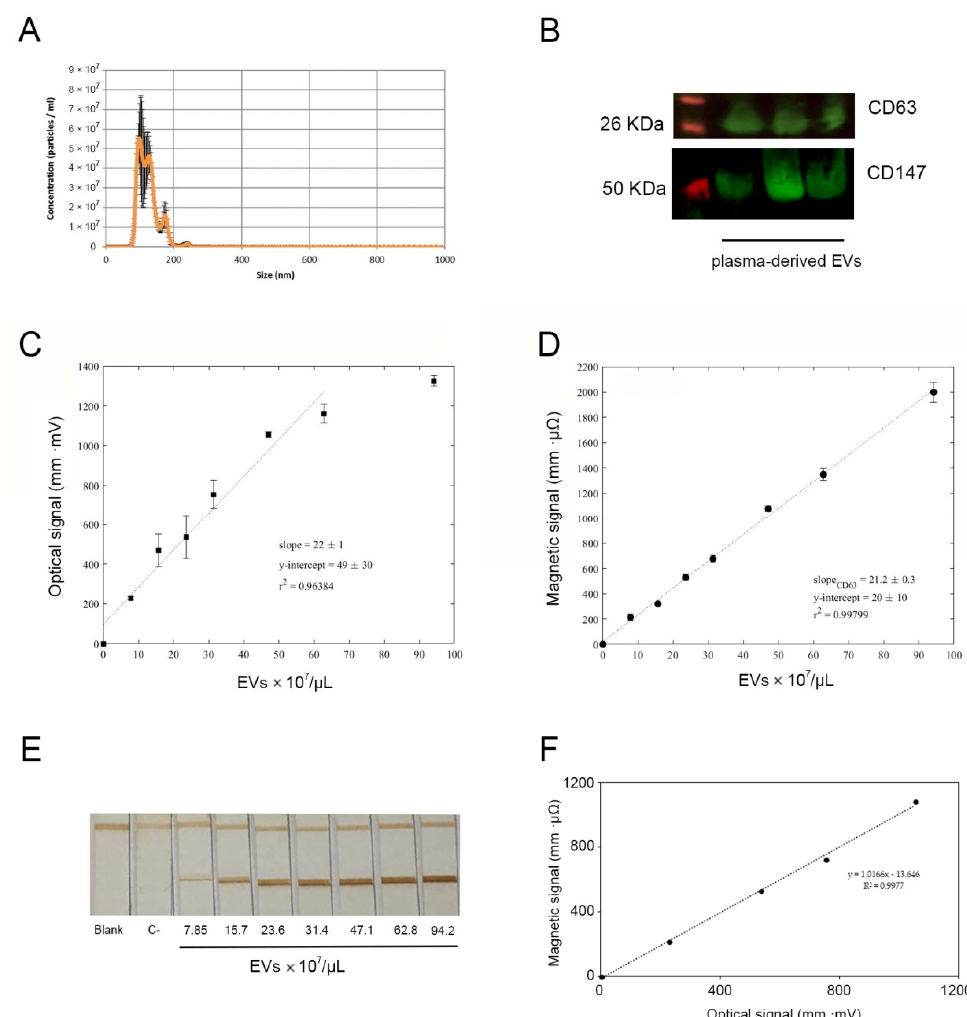
Figure 2. ( A ) Representative graph depicting the concentration and the hydrodynamic size distri- bution profiles of isolated EV, measured by NTA. ( B ) Western Blot analysis for detection of CD63 and CD147 in EVs fractions. Optical ( C ) and magnetic ( D ) calibration curve obtained in a range of EV concentrations, using anti-CD9 as capture antibody and MNP-anti-CD63 as detection probe. The measurements were obtained in triplicate; the graph shows the mean +/- standard deviation (SD) ( E ). Representative immunostrip tests obtained in the calibration experiments. ( F ) Correlation analysis between the measured optical and magnetic signals of LFIA strips for CD63 detection from 0 to 62.8 × 10 7 EVs/ μ L. Table 1. Analytical Figures of merit for quantification of EVs by optical and magnetic signals of magnetic nanoparticles. Quantification Lineal